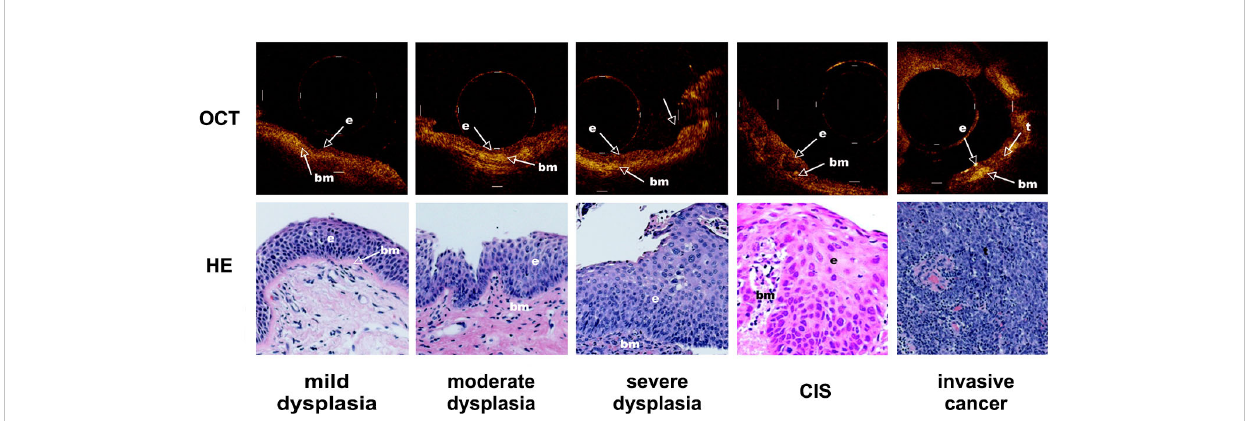
FIGURE 4 Demonstrated the dynamic process of lung cancer from middle dysplasia to invasive cancer. Representative OCT images of an area with mild dysplasia, moderate dysplasia, severe dysplasia, cancer in situ (CIS) and invasive cancer and corresponding H&E-stained histologic sections was showed. The picture was cited from Stephen Lam, Beau Standish, Corisande Baldwin, Annette McWilliams, Jean leRiche, Adi Gazdar, Alex I. Vitkin, Victor Yang, Norihiko Ikeda, Calum MacAulay; In vivo Optical Coherence Tomography Imaging of Preinvasive Bronchial Lesions. Clin Cancer Res 1 April 2008; 14 (7): 2006 – 2011.